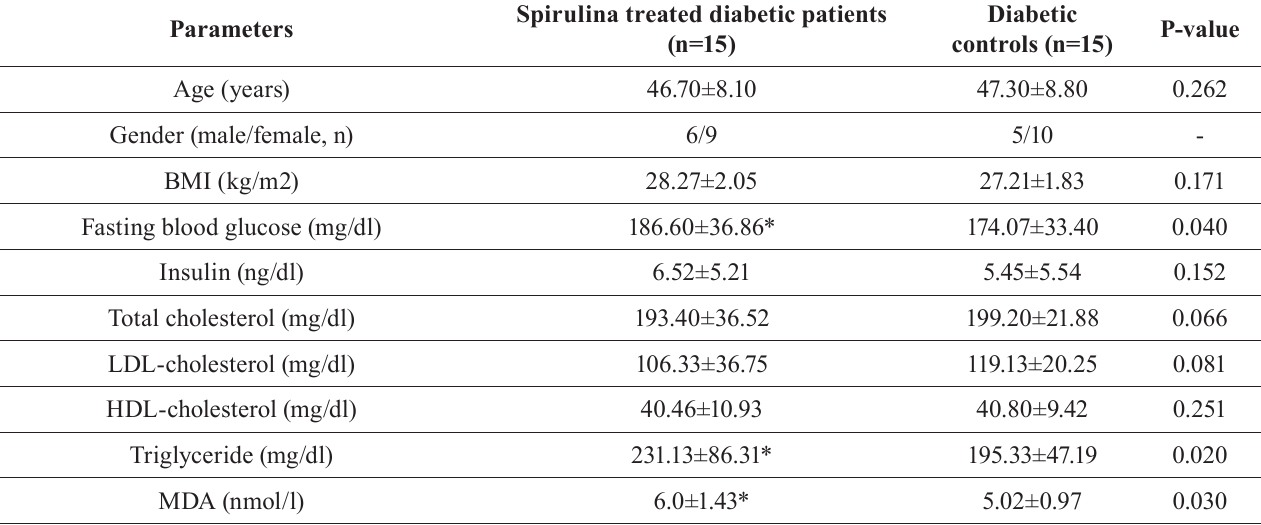
TABLE II - Baseline characteristics of study subjects